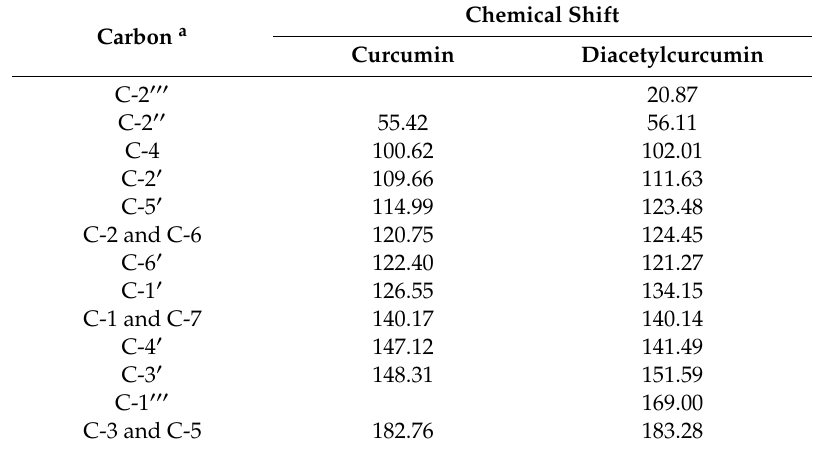
Table 2. 13 C-NMR spectral data of curcumin and diacetylcurcumin (DAC) (125.7 MHz) a . Carbon